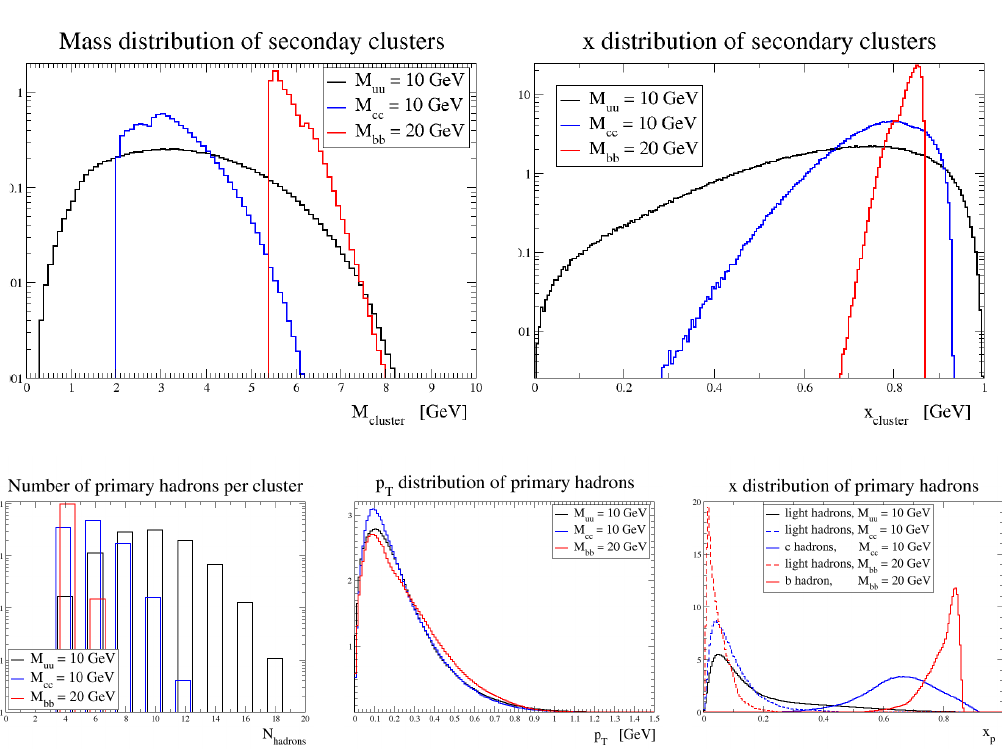
Figure 2: Mass distributions of secondary clusters produced in the decays of clusters of different mass and flavour composition (upper left), the corresponding multiplicity of primary hadrons (lower left), their transverse momenta with respect to the axis defined by the momenta of the original cluster constituents (lower middle), and the longitudinal momentum fractions (lower right). The parameters from Tab. 4, have been